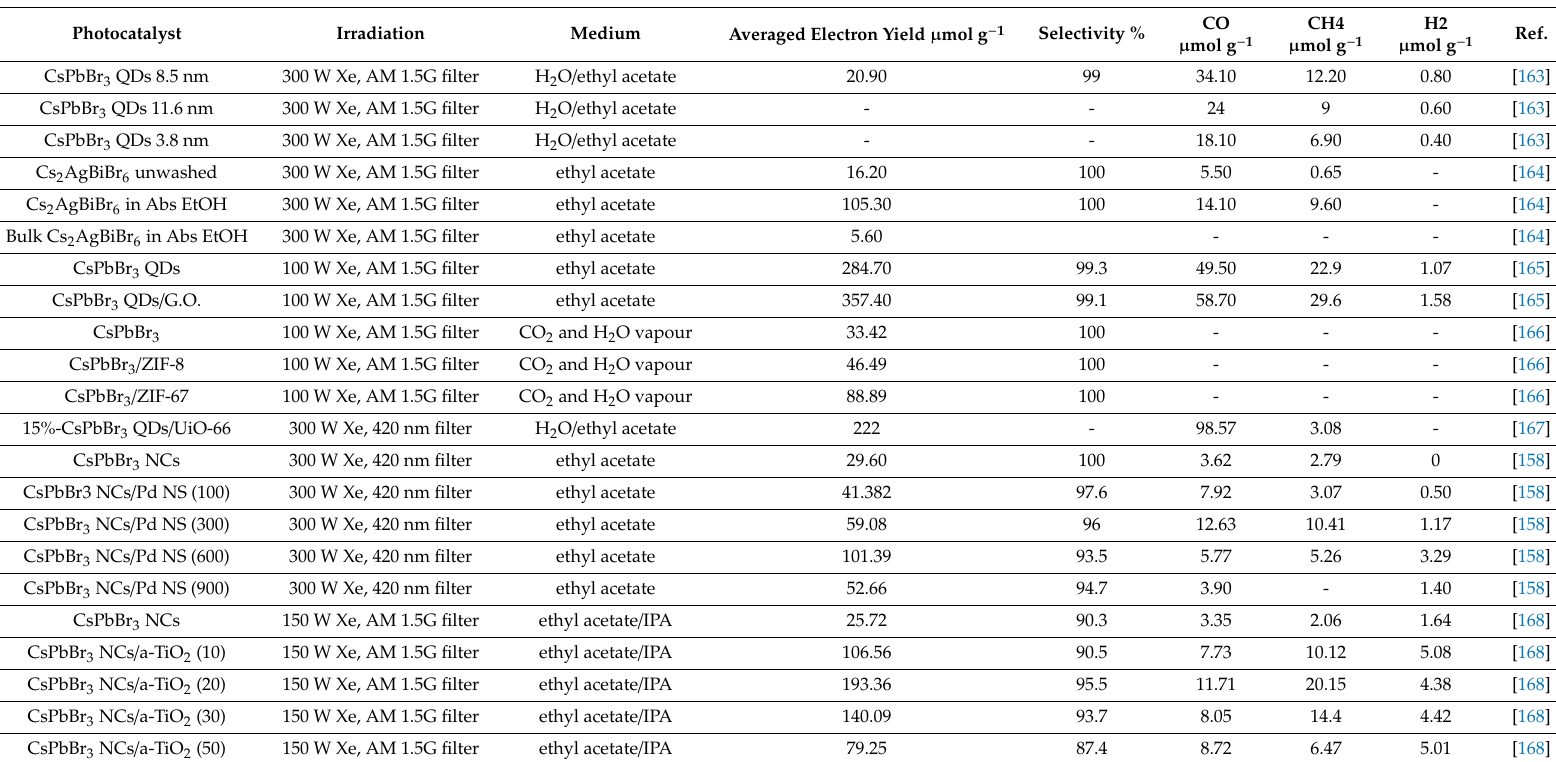
Table 2. Comparison of CO 2 reduction e ffi ciency of di ff erent metal halide perovskites-based photocatalysts reported in the